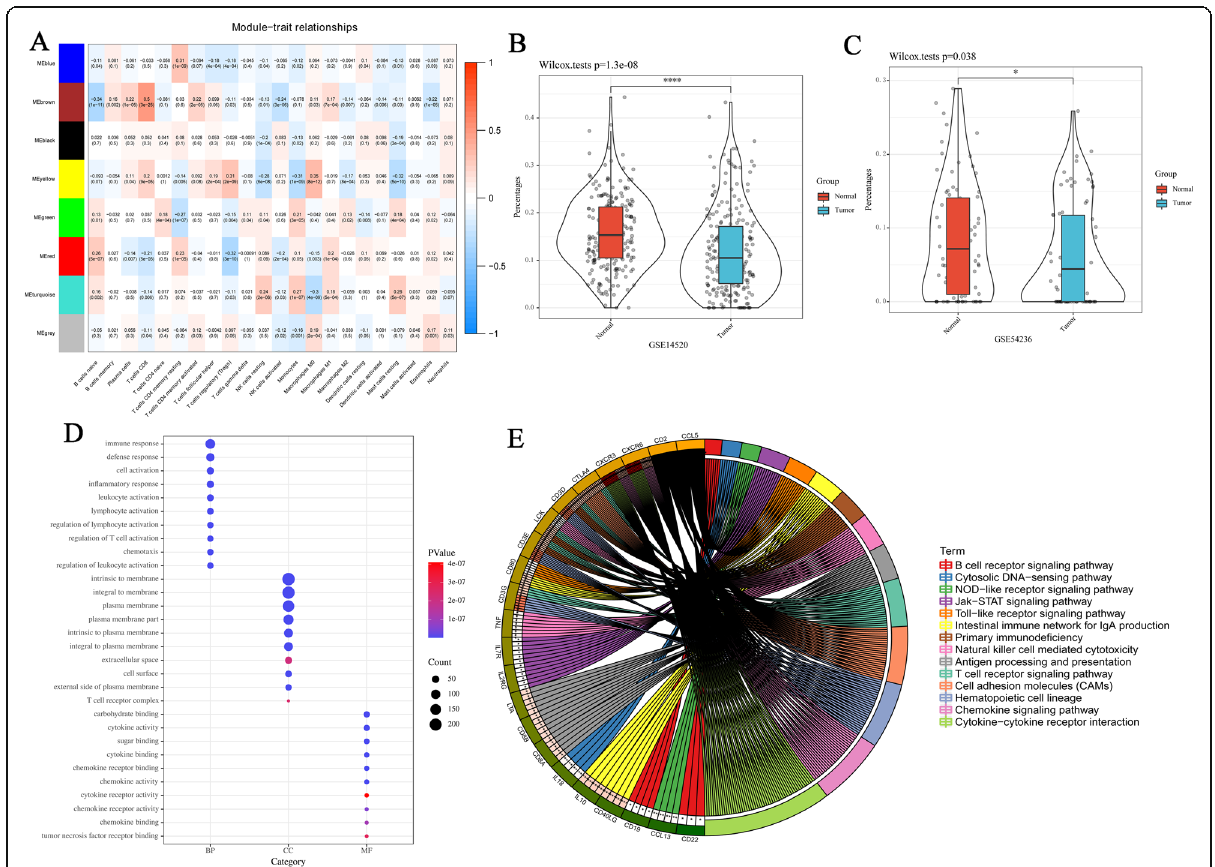
Fig. 3 Identification and functional enrichment of hub modules. A Heatmap showing associations between the module characteristic genes and immune cell infiltration. B CD8 + T cell infiltration in HCC samples and adjacent non-tumor samples from the GSE14520 dataset. Normal and Tumor indicate adjacent non-tumor samples and HCC samples, respectively. C CD8 + T cell infiltration in HCC samples and adjacent non-tumor samples from the GSE54236 data set. Normal and Tumor indicate adjacent non-tumor samples and HCC samples, respectively. D Significantly enriched GO terms. GO: Gene Ontology; BP: Biological process; CC: Cell composition; MF: Molecular function. E Significantly enriched KEGG pathways. For KEGG analysis, different colors represent different signaling pathways. KEGG, Kyoto Encyclopedia of Genes and